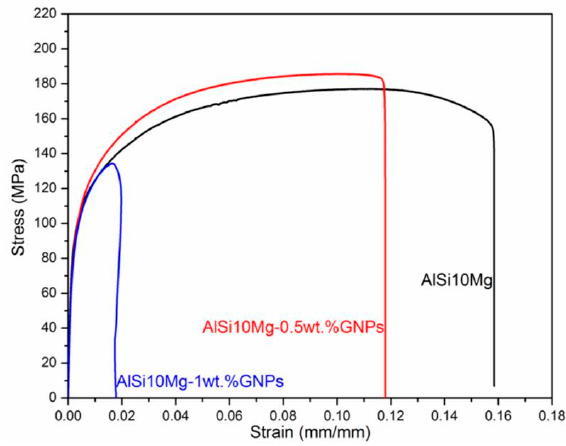
Figure 12. Tensile stress-strain curves of AlSi10Mg/GNPs curves produced by hot rolling [132], Reproduced from [132], with permission from Springer Nature, 2018.